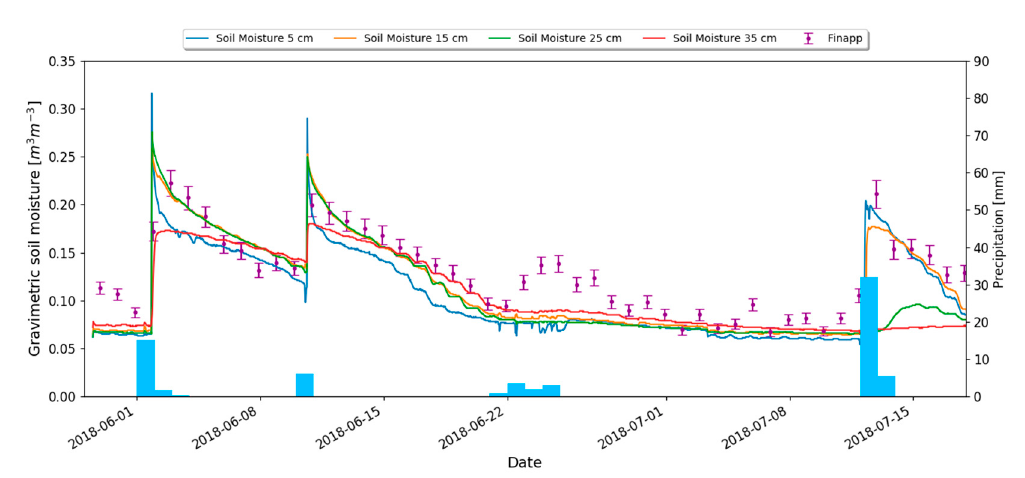
Figure 8. Gravimetric soil moisture from classical time domain reflectometry (TDR) probes (blue, orange, green, red) at different depths. The magenta points are CRNS gravimetric soil moisture using Desilet formula [19] and epithermal counts from Finapp. Daily rain is reported in the bottom part of the plot.